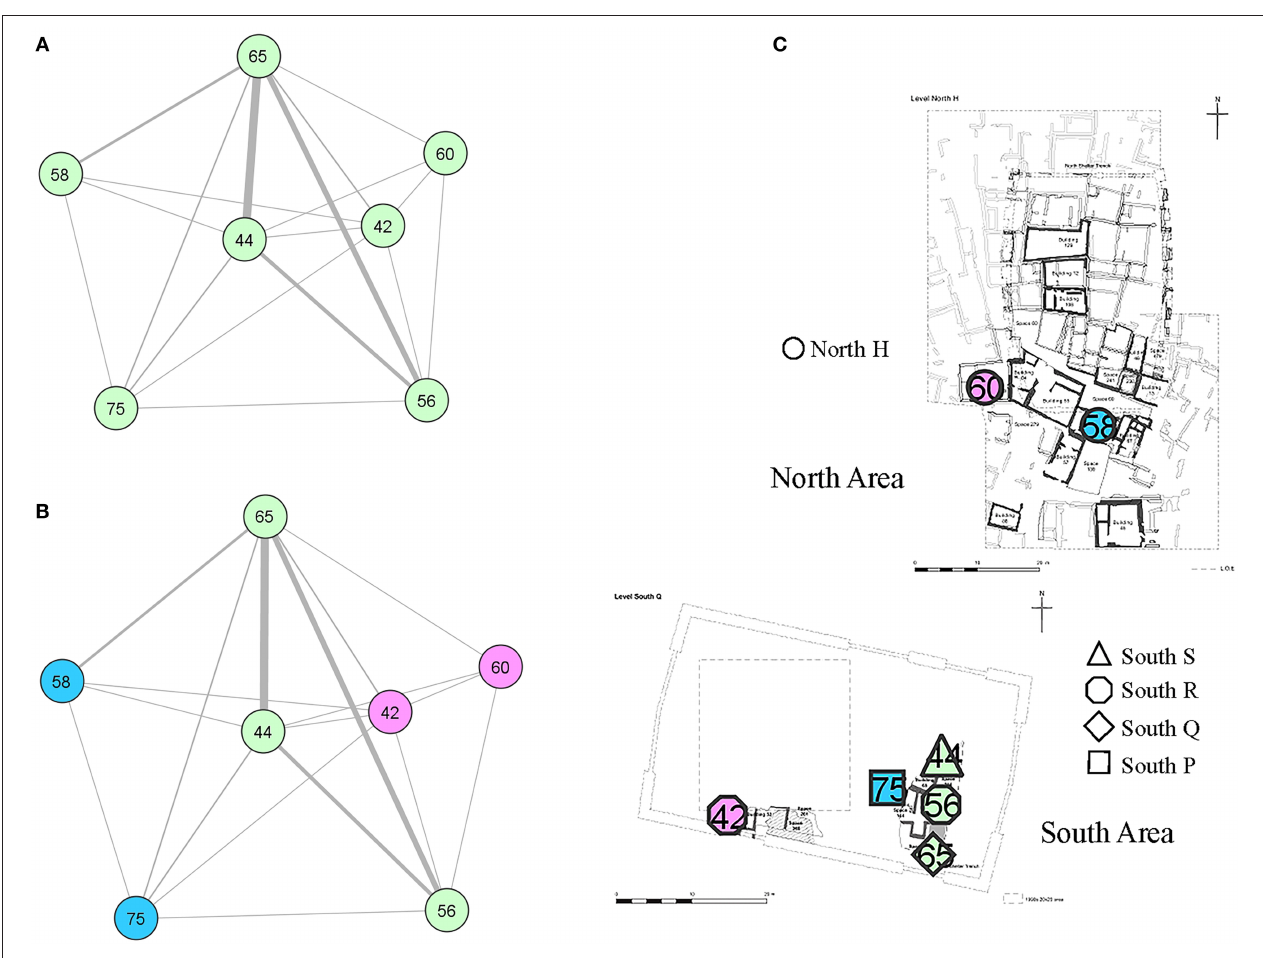
FIGURE 11 | Late network (A) . Louvain algorithm partition: layer 1 (B) and layer 2 (C) . Early network overlapped to the South Area excavation